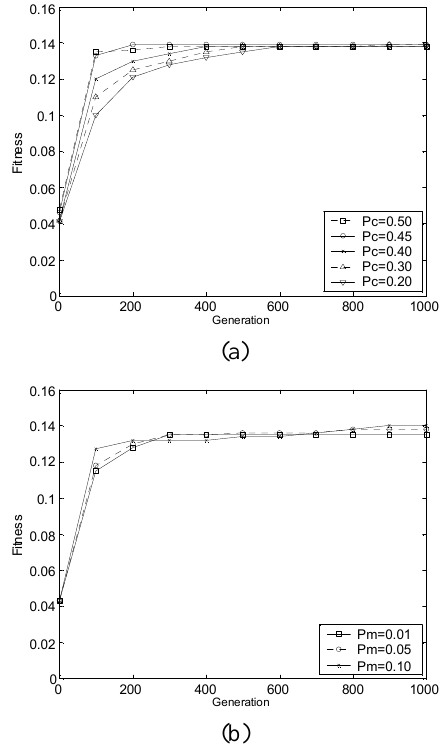
Fig. 7 Parameter choices for crossover and mutation probabil-